Question: Give a one-sentence summary of this figure.
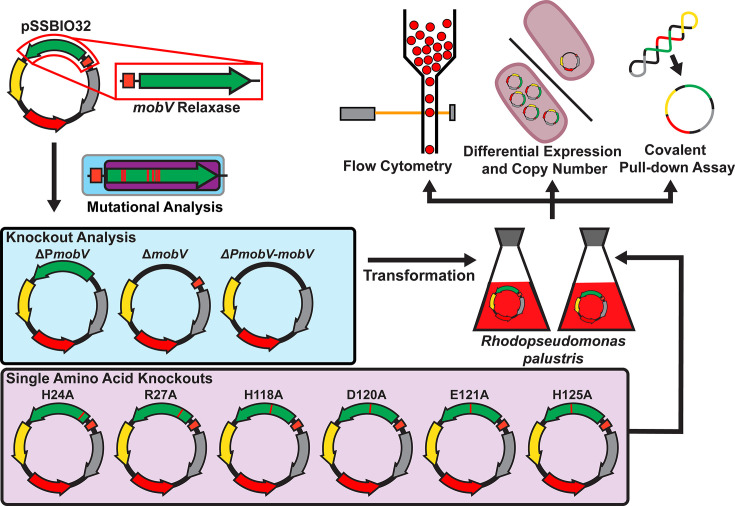
Answer: Methodology of testing MobV mutant’s performance in Rhodopseudomonas palustris . Vectors containing various mutations to mobV were constructed and inserted into R. palustris . Cultures were then evaluated through various metrics to determine each mutation’s effect on plasmid stability and gene expression rates. Flow cytometry was used for determining overall plasmid retention rates by cultures, RT-qPCR was used to determine relative expression levels of the different constructs, and proteins of several of the MobV mutants were purified to perform in vitro plasmid relaxation assays.